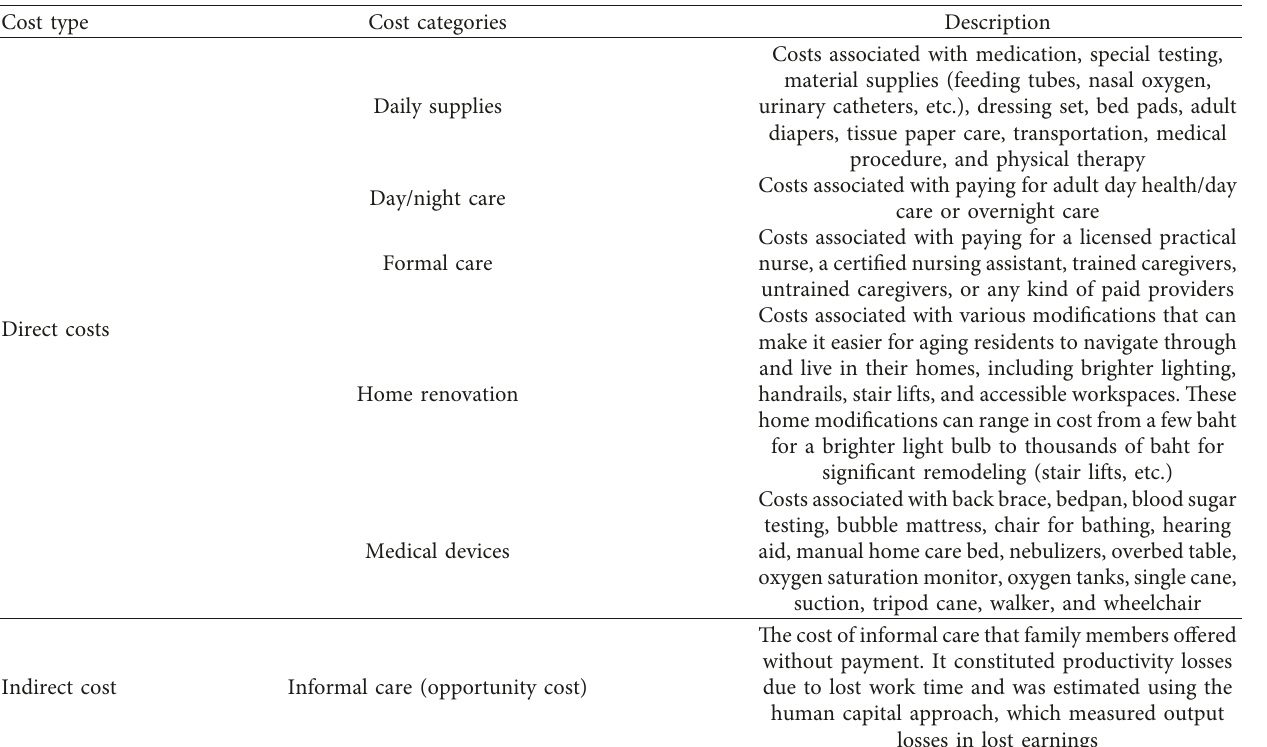
Table 1: Description of cost